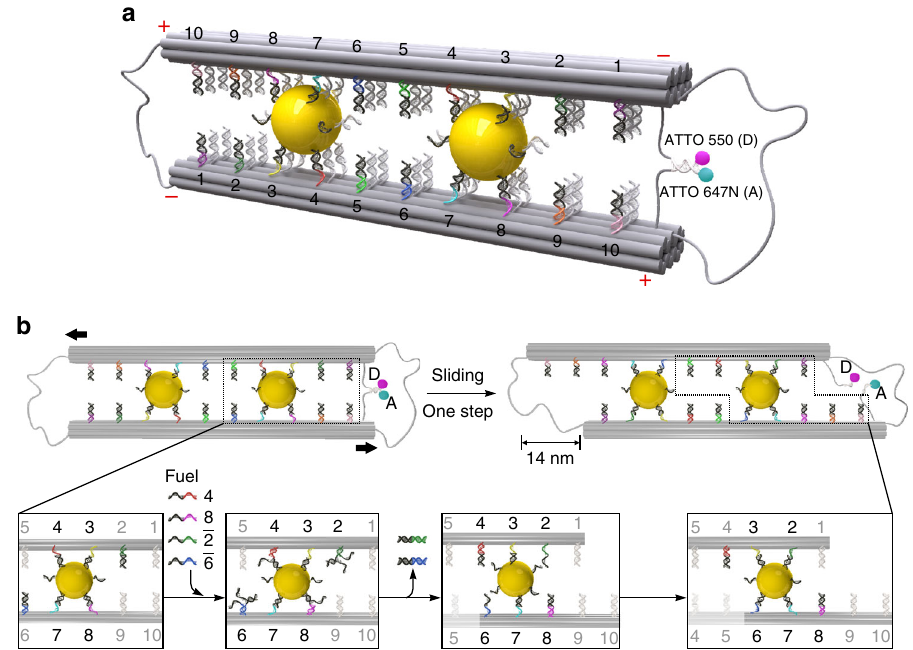
Fig. 1 Schematic of the sliding system and working principle. a Two gold nanocrystals (AuNCs, 10 nm) crosslink two DNA origami fi laments in antiparallel. Each fi lament comprises ten rows of footholds (coded 1 – 10) with 7 nm spacing. The foothold rows are reversely positioned along the two fi laments, which possess opposite polarities as indicated using ‘ + ’ and ‘ – . ’ The fi laments are connected by the scaffold strand to ensure a correct conformation as well as to enable structural fl exibility. A pair of fl uorophores (donor: ATTO 550 and acceptor ATTO 647 N) are tethered at one end of the origami to allow for in situ optically monitoring the sliding dynamics via fl uorescence resonance energy transfer (FRET). D and A represent donor and acceptor, respectively. b Upon addition of blocking strands 4 and 8, and removal strands 2 and 6, toehold-mediated strand displacement reactions take place. Rows 4 and 8 are blocked and the AuNCs are released from these rows. Meanwhile, rows 2 and 6 are activated to bind the AuNCs. As a result, the two AuNCs slide the fi laments relative to one another for one step in a cooperative manner, introducing a 14 nm